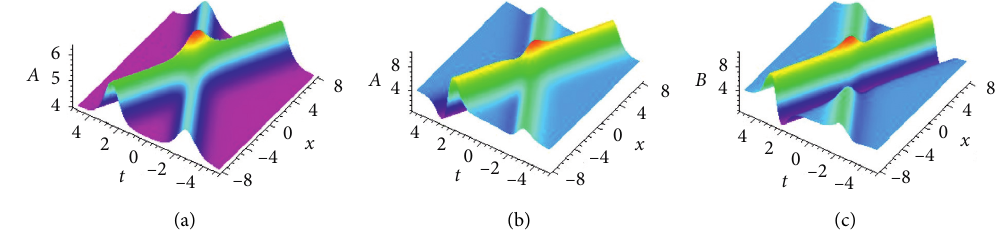
Figure 2: The two-soliton solution (21) with (a) b